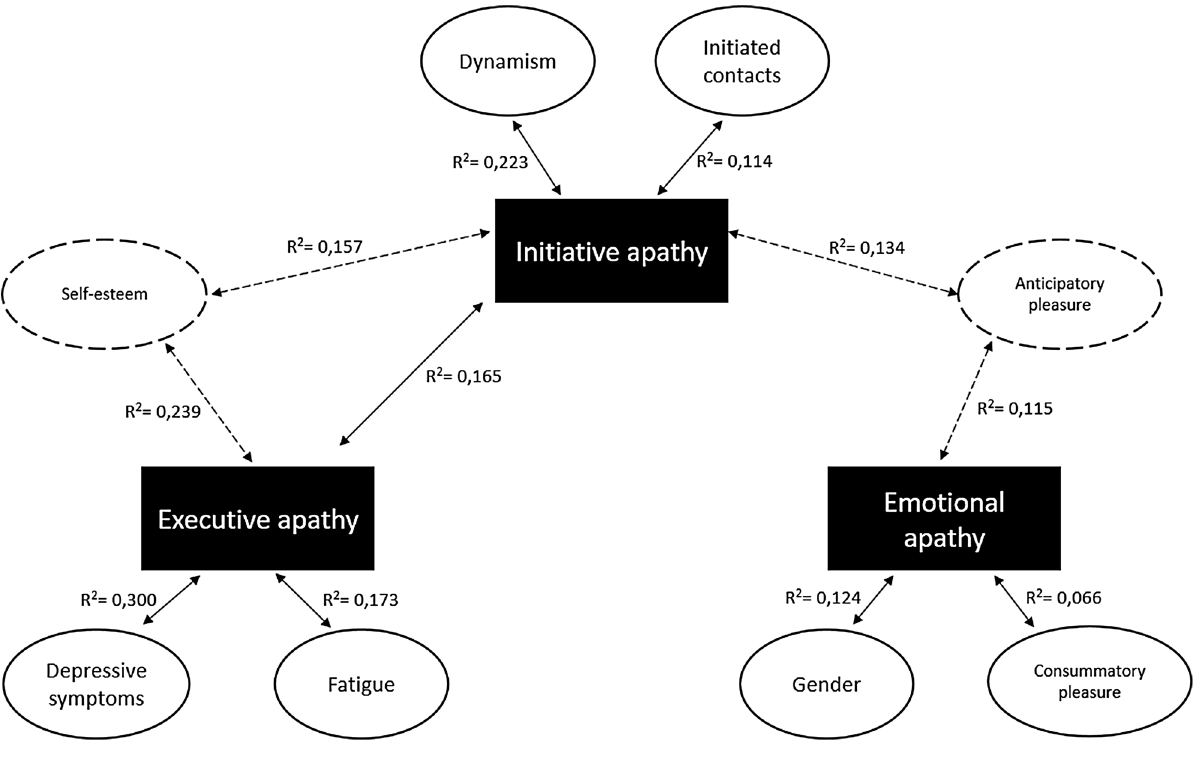
Figure 3. Predictors for the three forms of